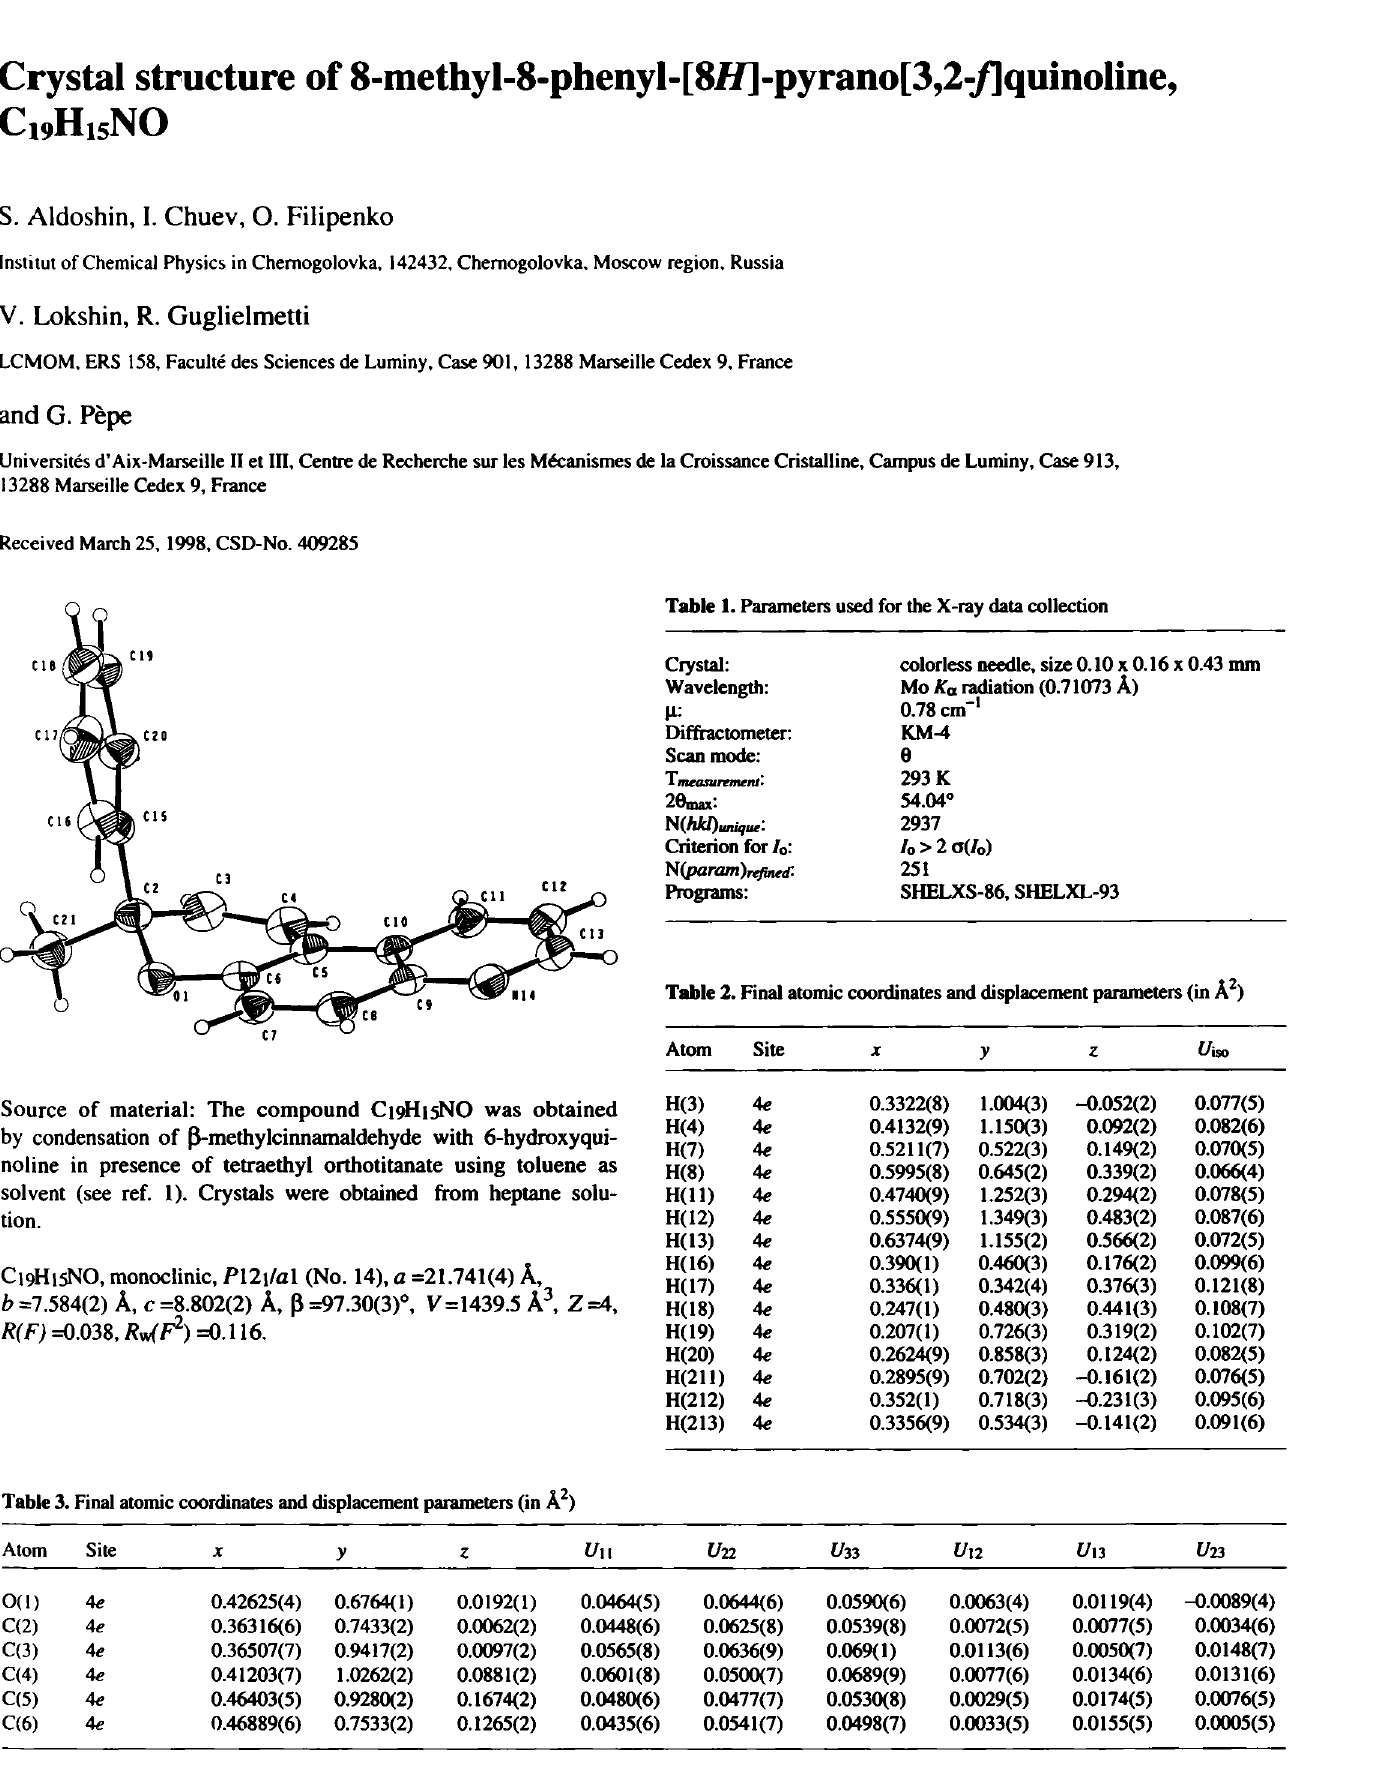
Table 1. Parameters used for the X-ray data collection Ciystal: